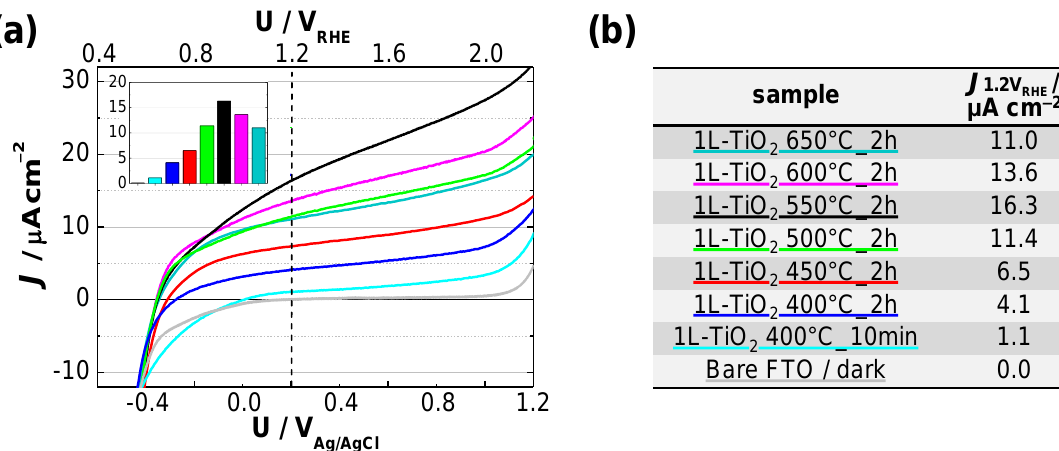
Figure 5. Influence of calcination temperature on photoelectrochemical water oxidation activity. ( a ) Voltammetric scans and ( b ) selected photocurrent densities for each corresponding calcination